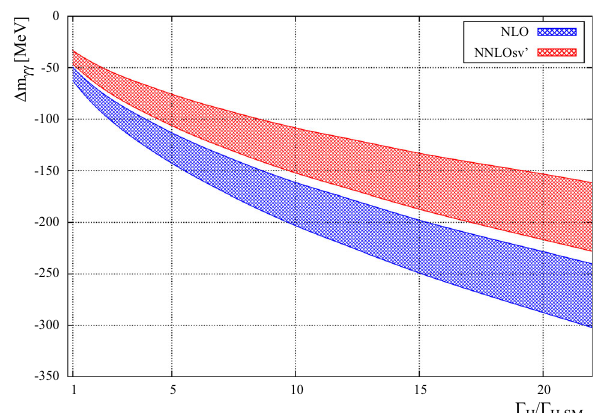
Fig. 6 Mass-shift as a function of the Higgs boson width